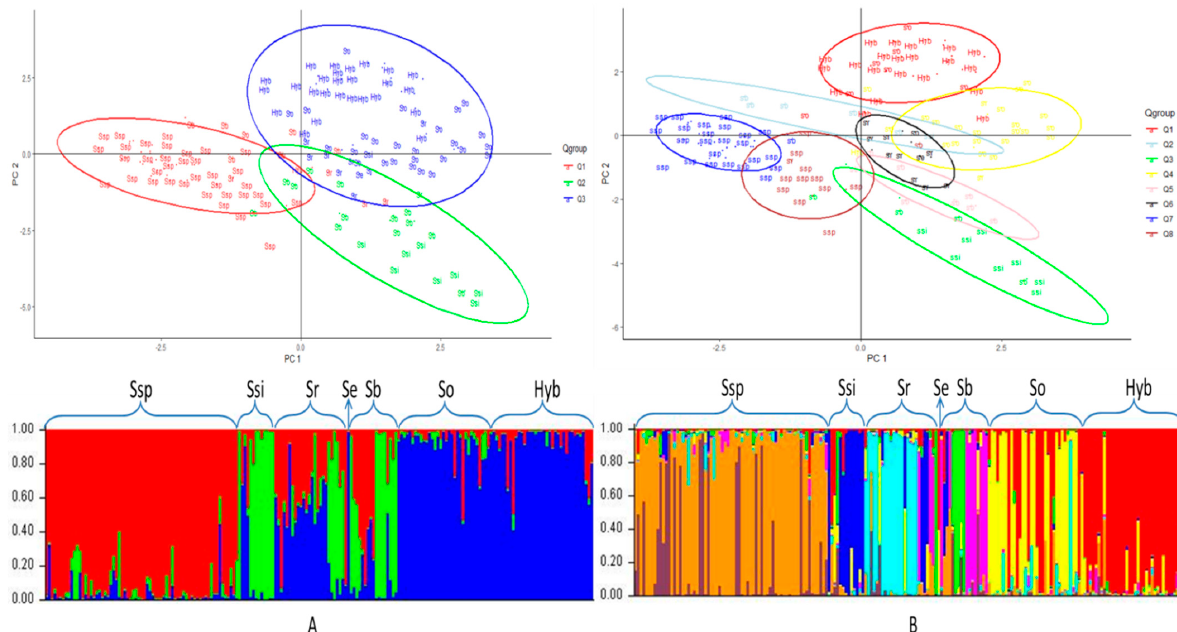
Figure 4. A scatter diagram of Principal Component Analysis (PCA) of the 196 accessions labeled by species as Saccharum spontaneum (ssp), S. robustum (sr), S. officinarum (so), S. sinense (ssi), S. barberi (sb), Saccharum spp. hybrids (Hyb), and S. edule (se), and marked by corresponding colors of K3 ( A ) and K8 ( B ) gene pools.